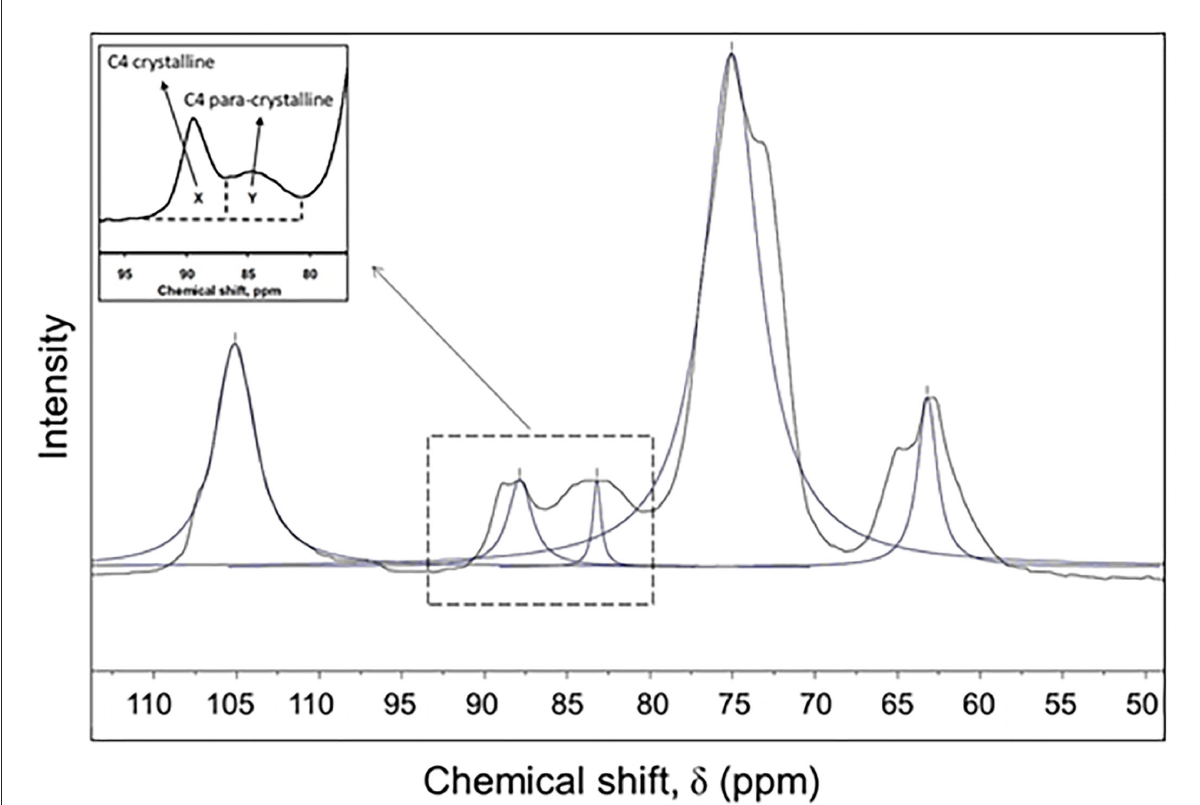
FIGURE2 Raw and deconvoluted CP-MAS spectra of cellulose extracted from A. donax . The two regions of the C4 peak (i.e., the range 86–92 ppm for the crystalline domains and the range 80–86 ppm related to the amorphous domains) used for the Cr.I. calculation are displayed in the